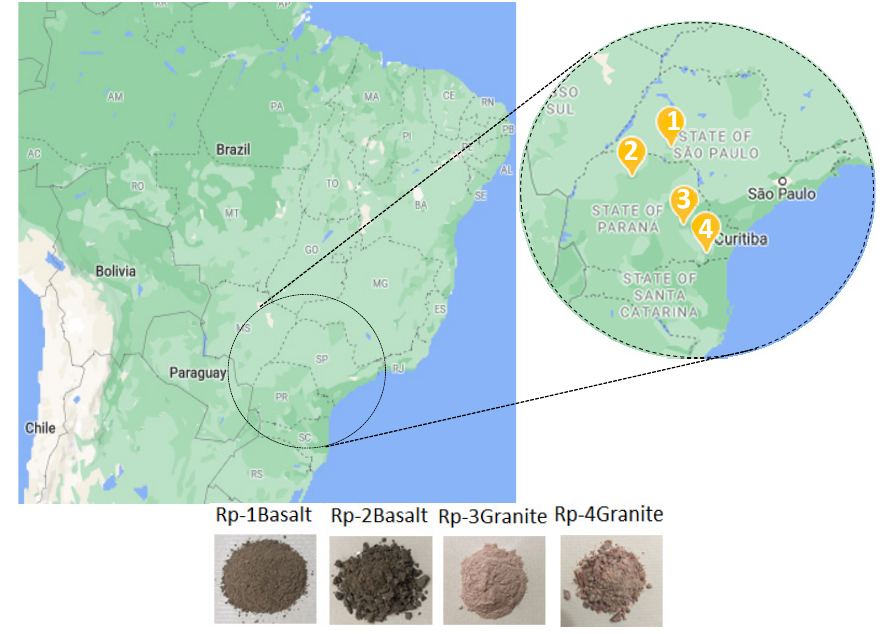
Figure 6. Rock powders used in the research. Rock exploration locations where samples were col- lected.